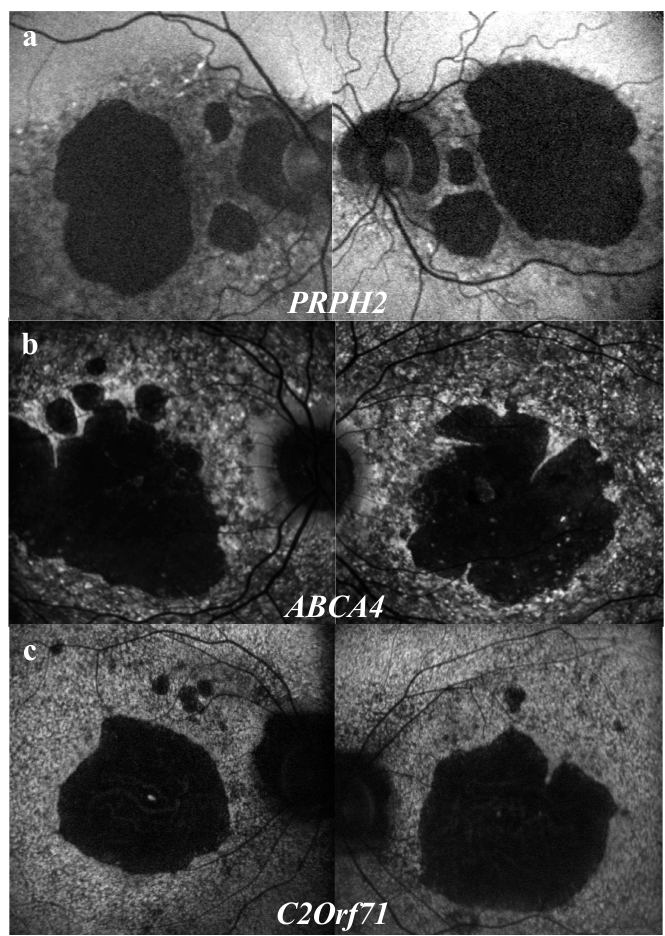
Figure 6. Characteristic features of the “speckled” aspect depending on the gene defect. ( a ) PRPH2 mutations: hyperAF spots are larger and less numerous, with reticular aspect, surrounding macular atrophy and the optic nerve. ( b ) ABCA4 mutations: hyperAF spots are more numerous and widespread, sparing classically the peripapillary region. ( c ) C2Orf71 mutations: hyperAF are smaller, leading to a granular aspect, extending beyond the vascular arcades without peripapillary sparing.